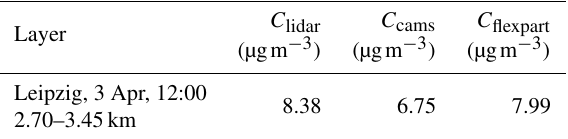
Figure 14. Range-corrected signal at 1064nm for Leipzig station, 3 April 2014. The red box represents the identified layer.